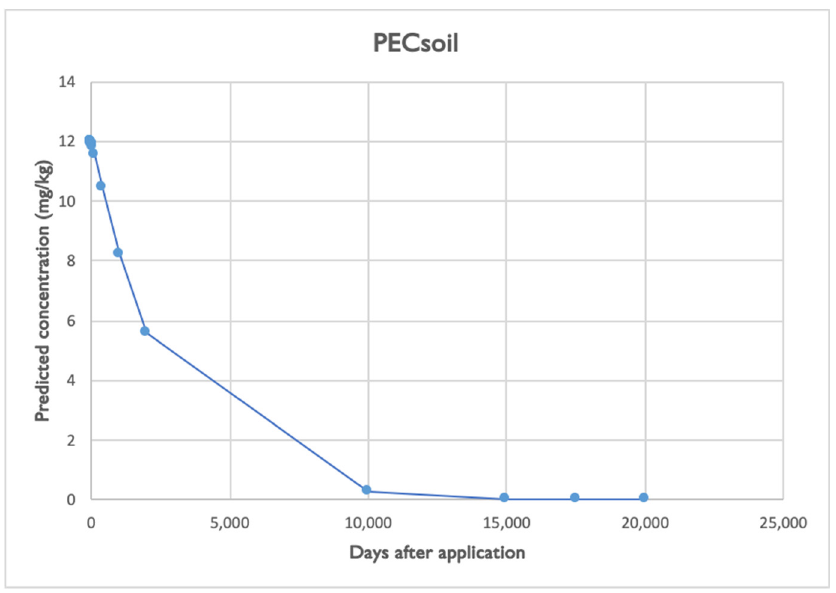
Figure 2. PECsoil decline curve.